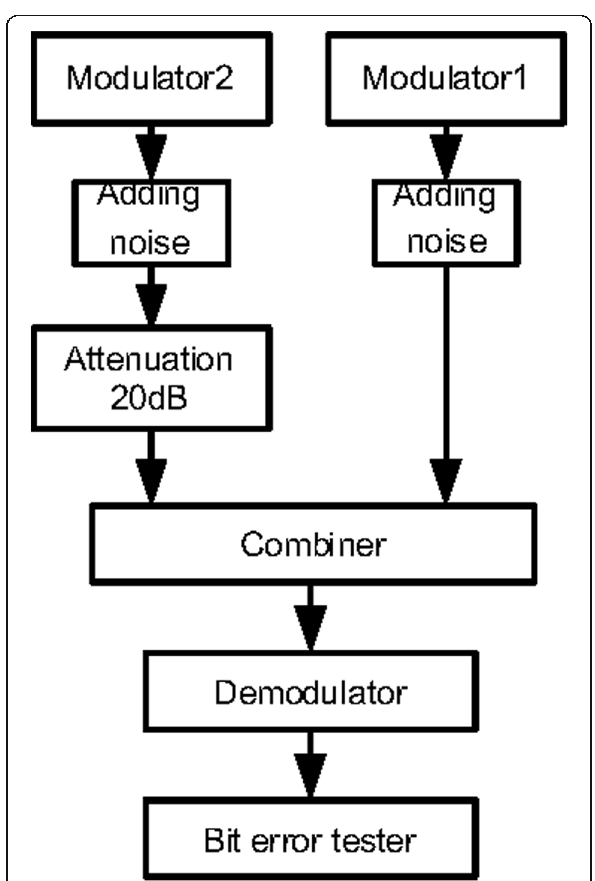
Fig. 6 Experiment principal diagram. This figure shows an